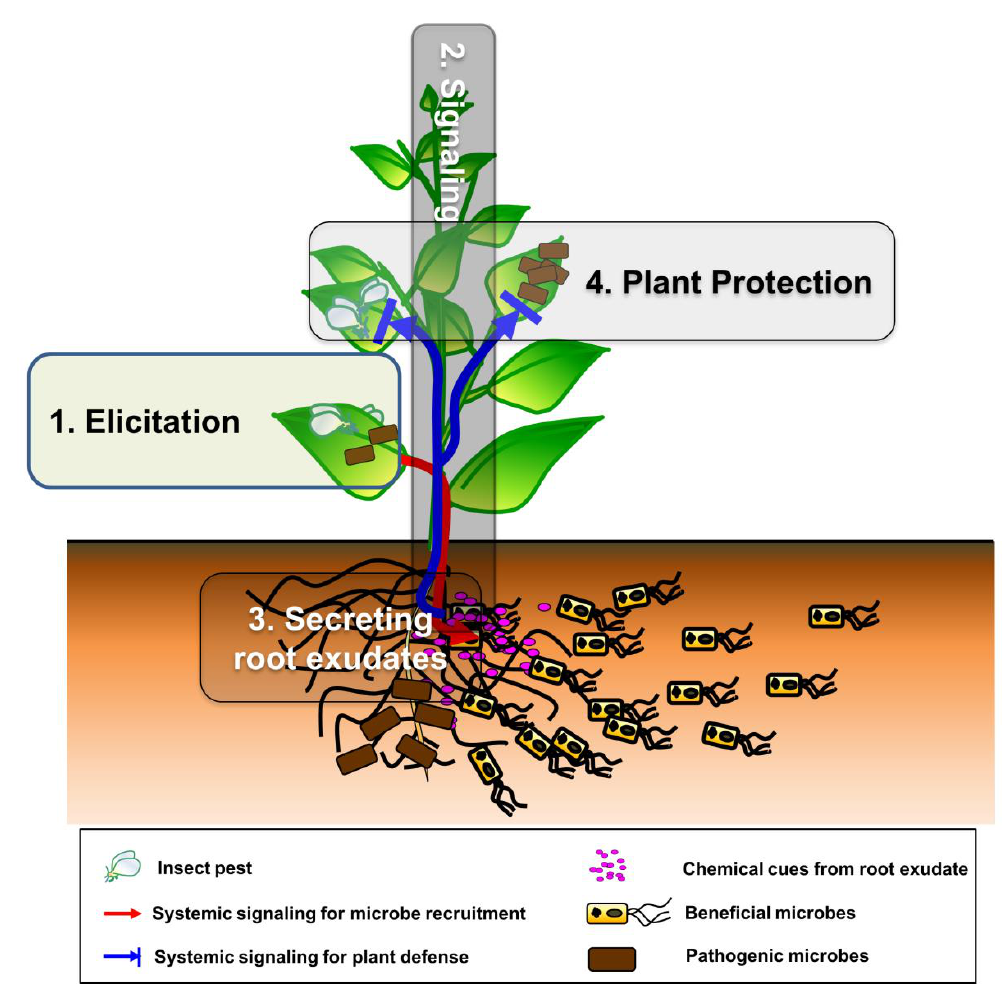
Figure 2. Schematic representation of the plant SNS. The events at each step of multitrophic interactions include (1) elicitation; (2) systemic signaling; (3) root exudate secretion; and (4) plant protection.